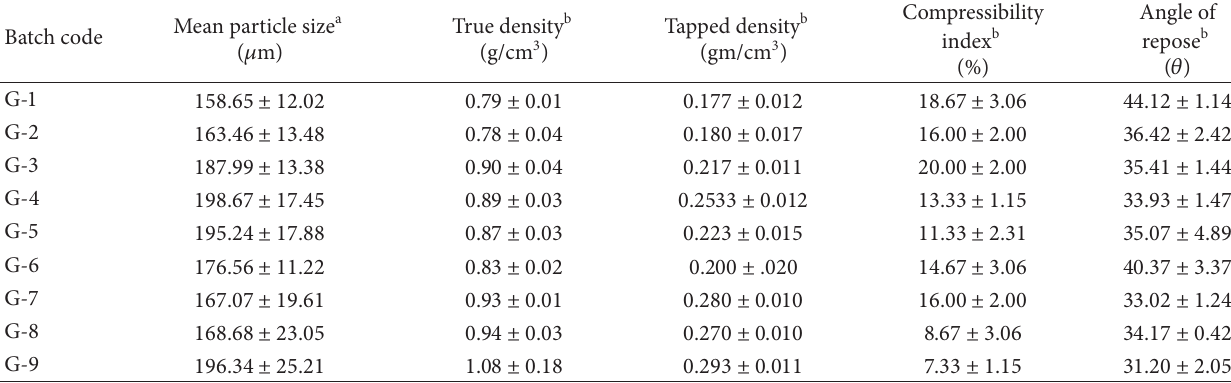
Table 2: Micromeritic properties of floating hollow microspheres.